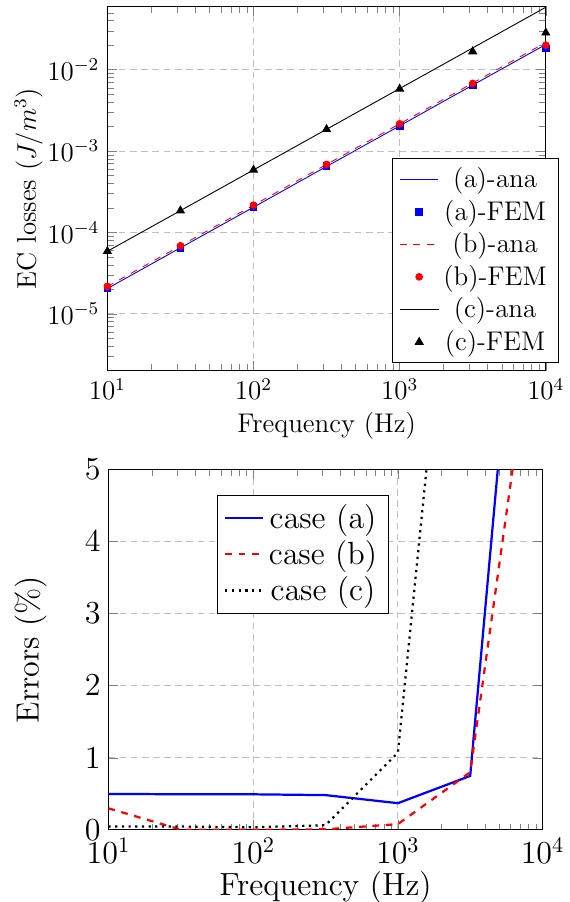
Figure 6: EC losses from homogenization model: compar- ison to FEM results and corresponding